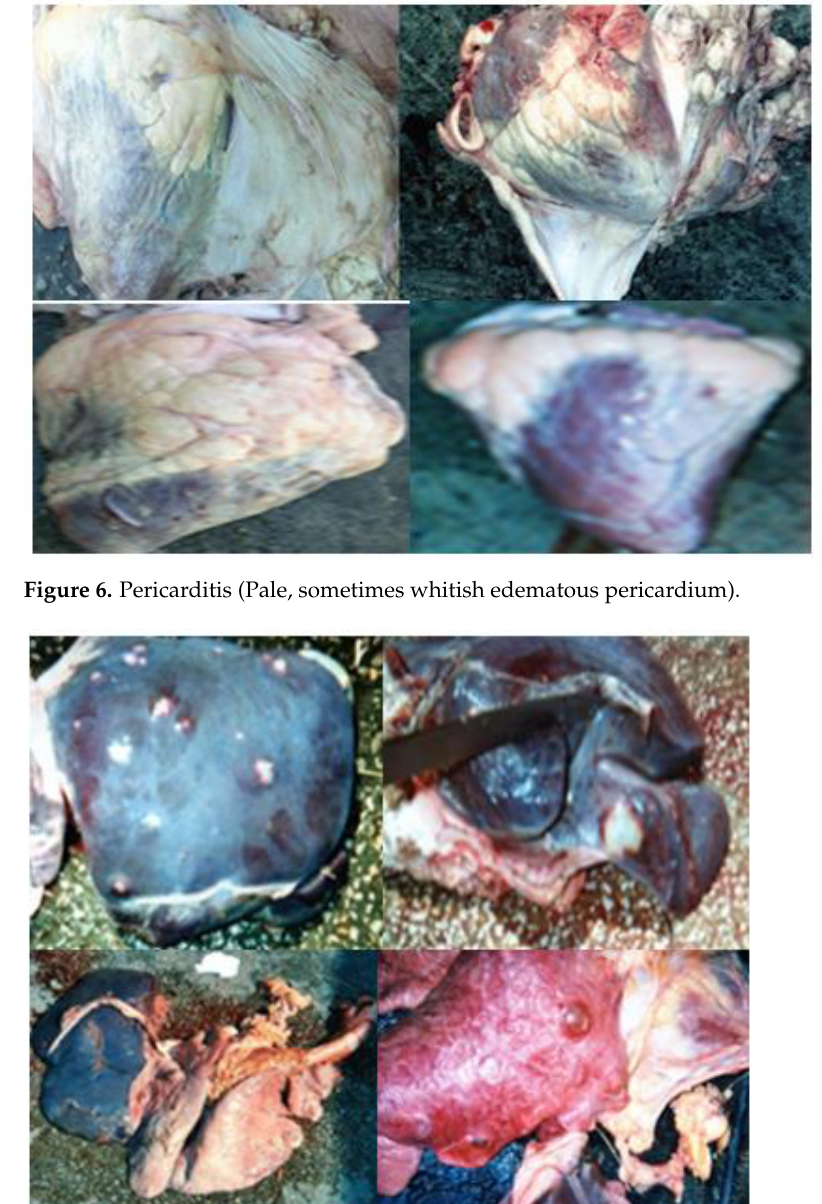
Figure 7. Hydatidosis (Lung and/or liver with a surface full of cysts of variable size with fluid content).